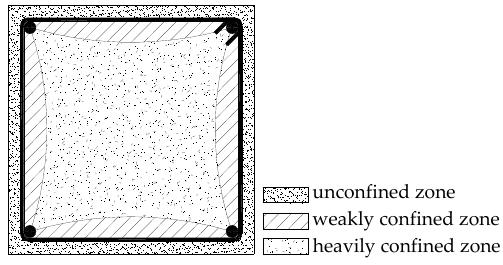
Figure 6. Schematic diagram of the confined area of the rectangular ties section.